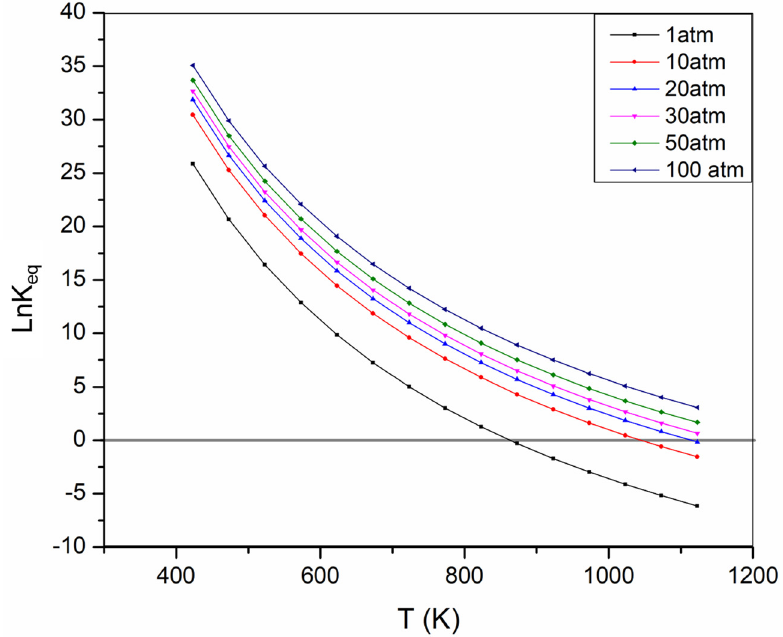
Figure 3. LnK eq versus T plot for CO 2 methanation (R1) at different pressure (H 2 /CO 2 ratio =